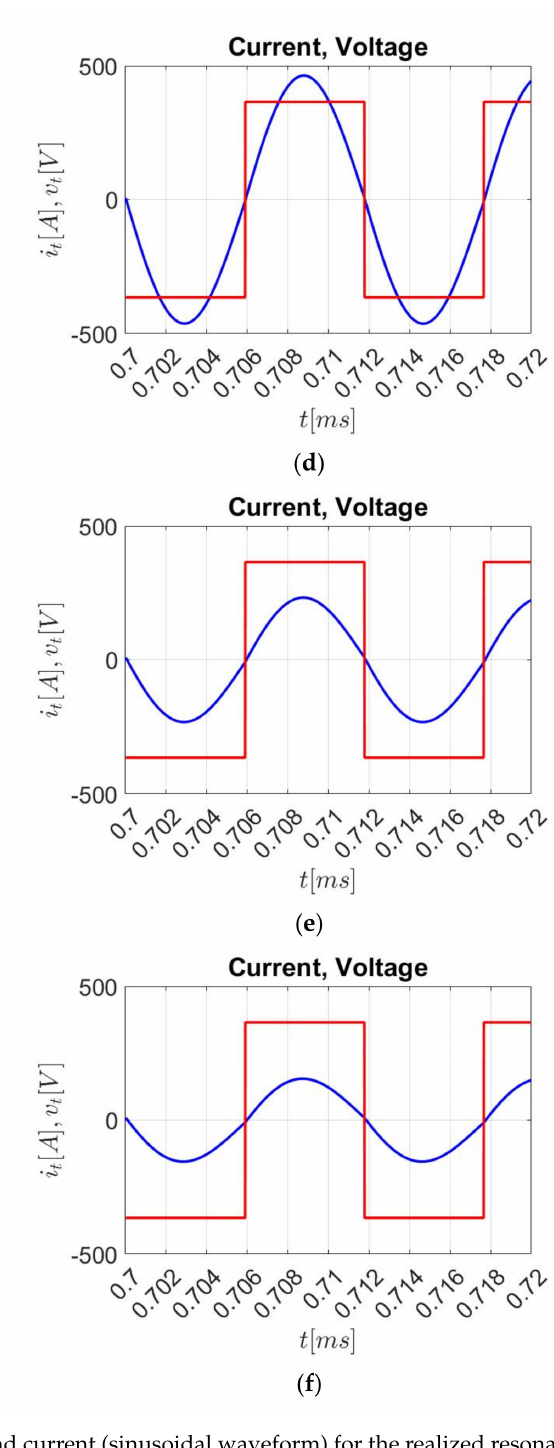
Figure 5. Voltage (quasi-square wave) and current (sinusoidal waveform) for the realized resonant inverter. Current is a multiple of five. ( a ) α P = π /4, R = 5 Ω ; ( b ) α P = π /4, R = 10 Ω ; ( c ) α P = π /4, R = 15 Ω ; ( d ) α P = π /3, R = 5 Ω ; ( e ) α P = π /4, R = 10 Ω ; ( f ) α P = π /3, R = 15 Ω